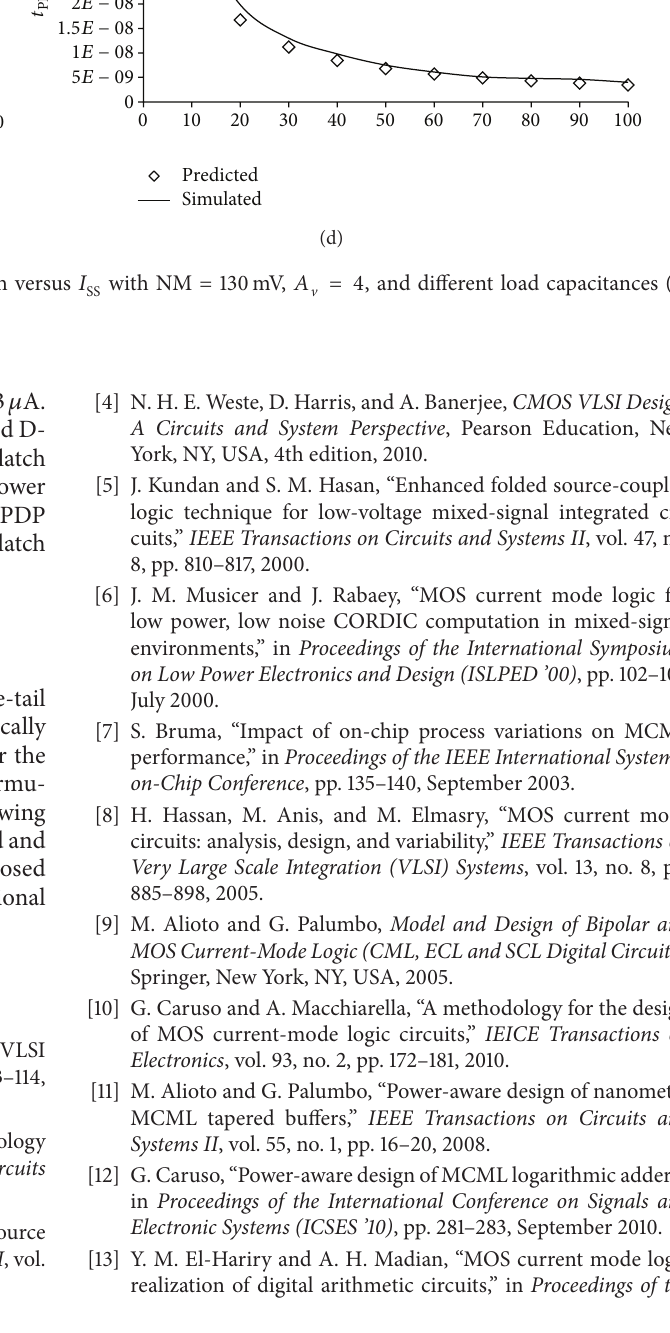
with NM = 130mV, 𝐴 SS